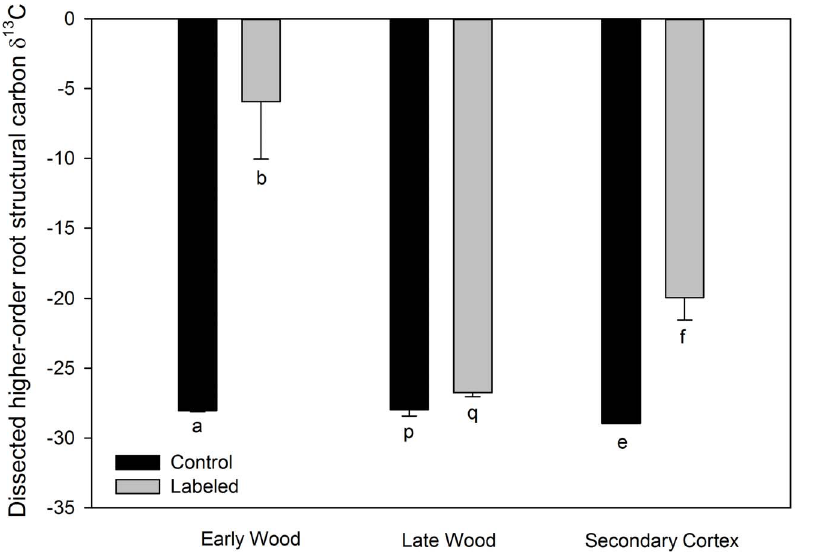
Figure 4. Mean Sassafrasalbidum root structural carbon d 13 C values from higher-order dissected roots. Trees were labeled and sampled in 2008. Control roots were sampled from unlabeled control trees and labeled roots were sampled from trees labeled with 99% 13 CO 2 . Late wood refers to the innermost portion of the dissected roots (see Figure 2). Early wood refers to the root tissue immediately surrounding the late wood. Secondary cortex refers to the outermost portion of the root surrounding the early wood. Note that less negative values indicate greater isotopic enrichment. Error bars denote standard error. Different lower case letters denote significant differences at P # 0.05 using a one tailed T-test between dissected root tissue from unlabeled control trees and labeled trees.